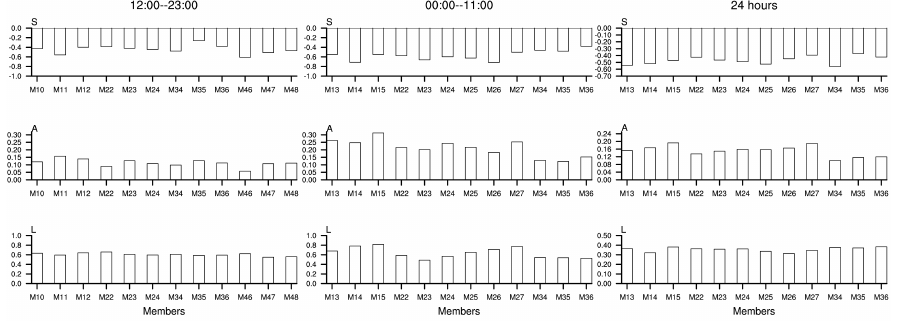
Figure 13. The four-case averaged Structure ( the first row ), Amplitude ( the second row ) and Location ( the third row ) metrics of 12 combination members consistent with Figure 10d ( the first column ), Figure 11g ( the second column ), and Figure 12g ( the third column ),